Question: In a single sentence, describe what this figure presents.
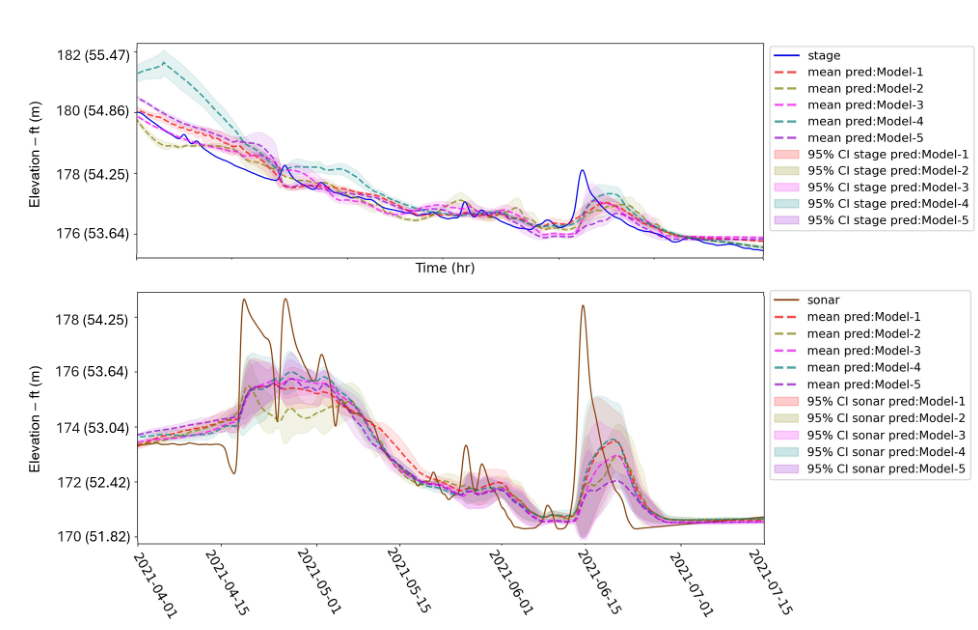
Answer: Stage (top) and Sonar (bottom) predictions of top-5 models selected by the meanMAE policy, showing the mean and 95% confidence interval over the test dataset - Luckiamute bridge.